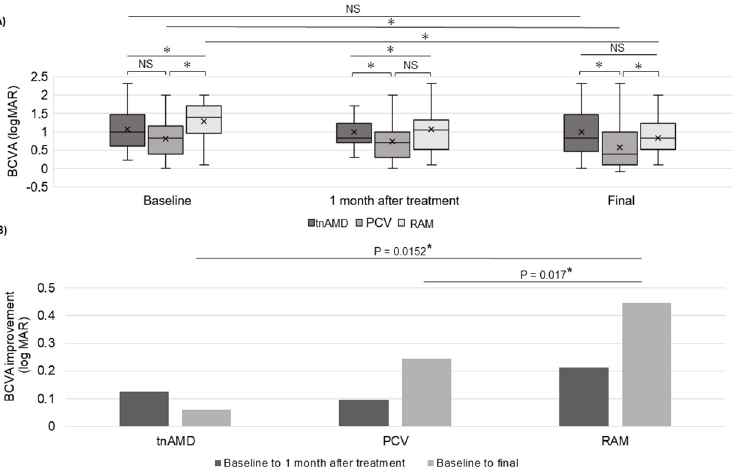
Fig 2. Comparison between the course of best-corrected visual acuity among the tnAMD, PCV and RAM groups. (A) Box plots of log MAR best-corrected visual acuity scores at baseline, 1 month, and at the final visit. (B) Improvement in the logMAR best-corrected visual acuity scores from baseline. BCVA: best-corrected visual acuity, logMAR: logarithm of minimum angle resolution, tnAMD: typical neovascular age-related macular degeneration, RAM: retinal arterial microaneurysm, PCV: polypoidal choroidal vasculopathy, NS: not significant. � P < 0.05. Statistical methods used were Wilcoxon’s rank test and paired t -test.